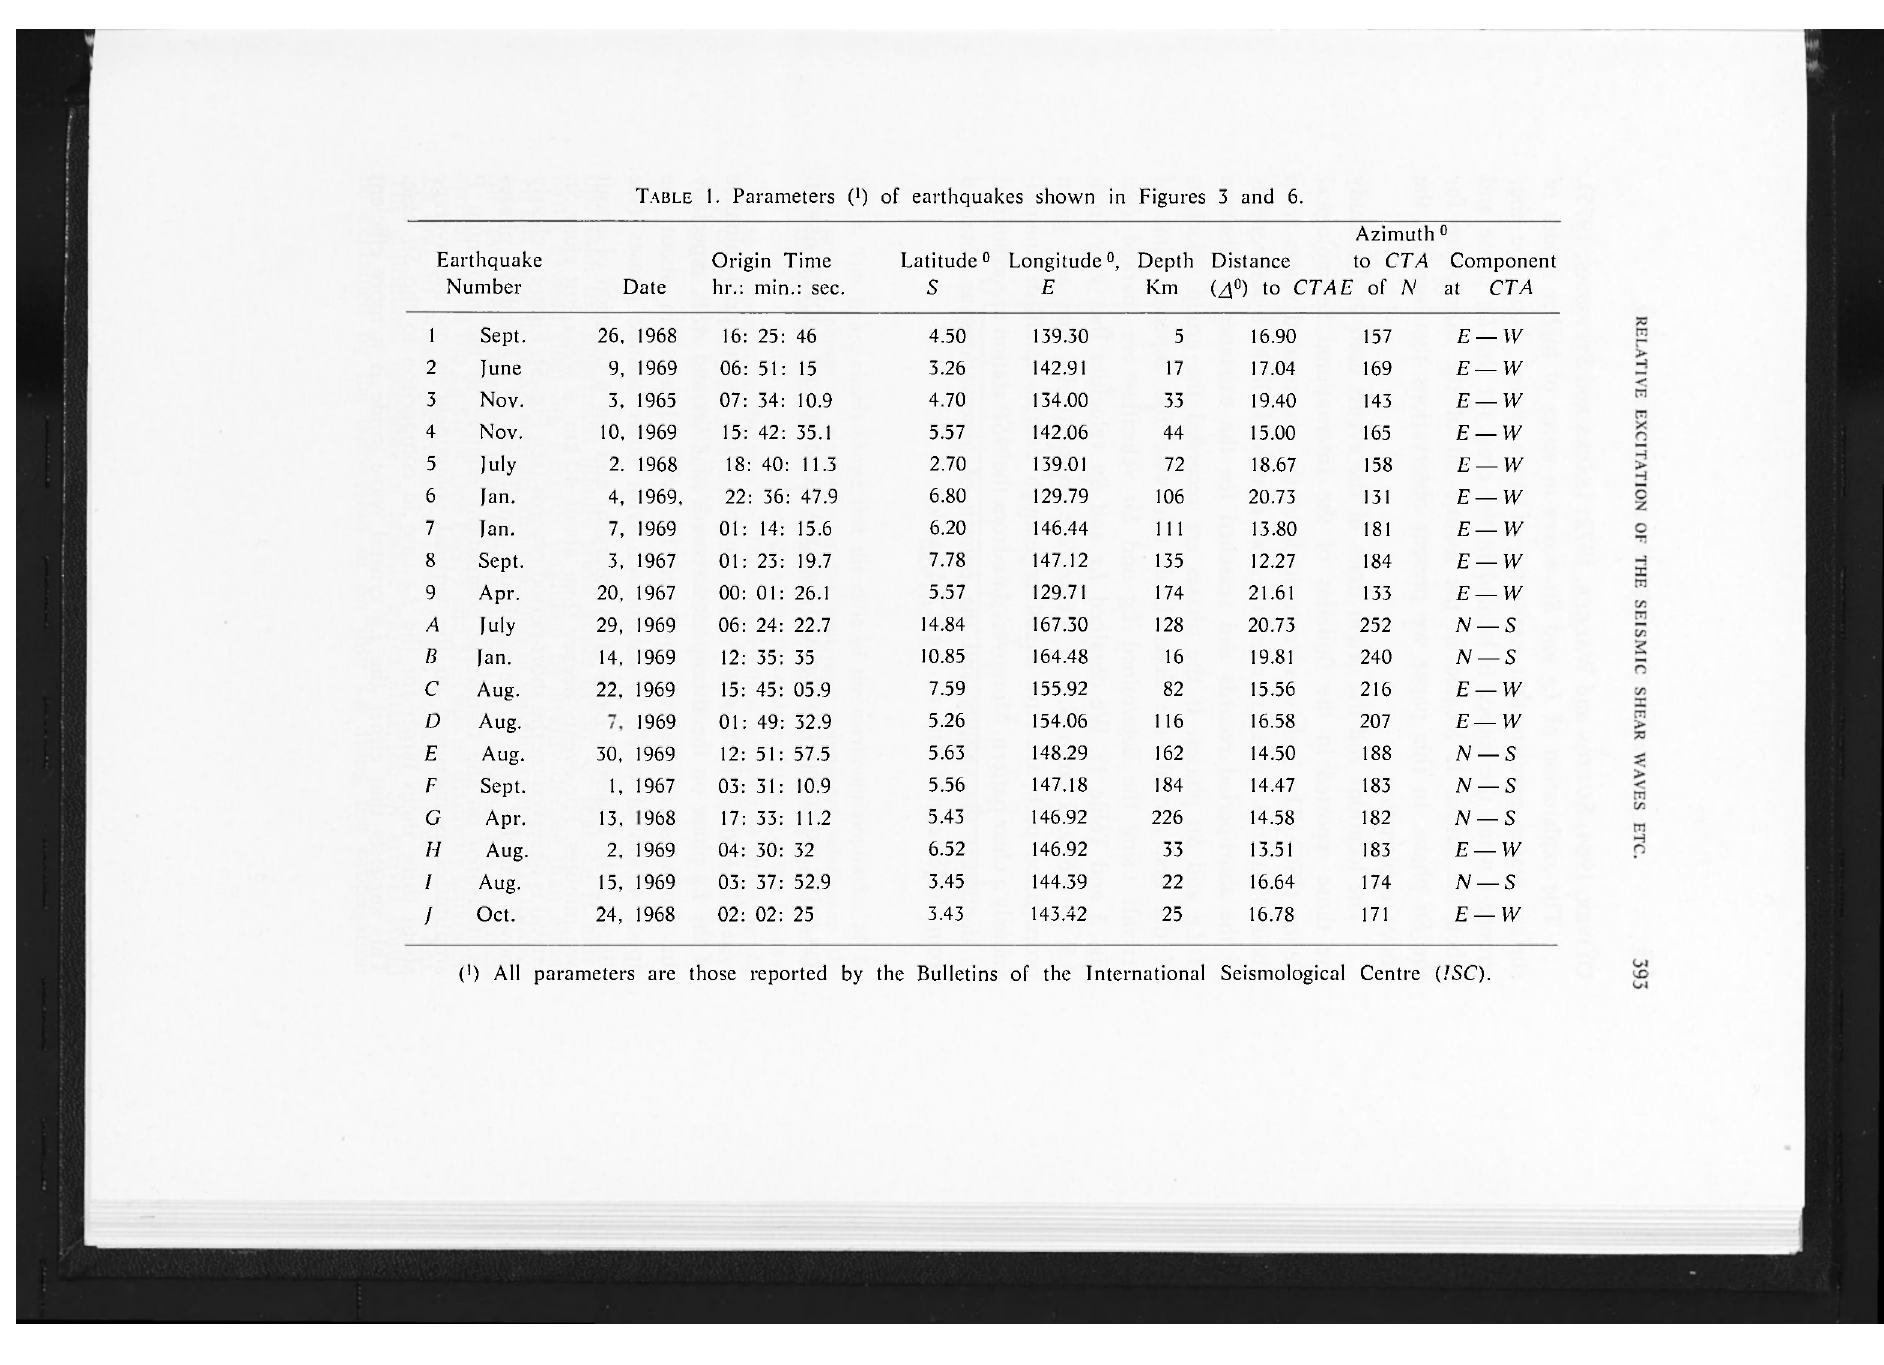
TABLE 1. Parameters (') of earthquakes shown in Figures 3 and 6.